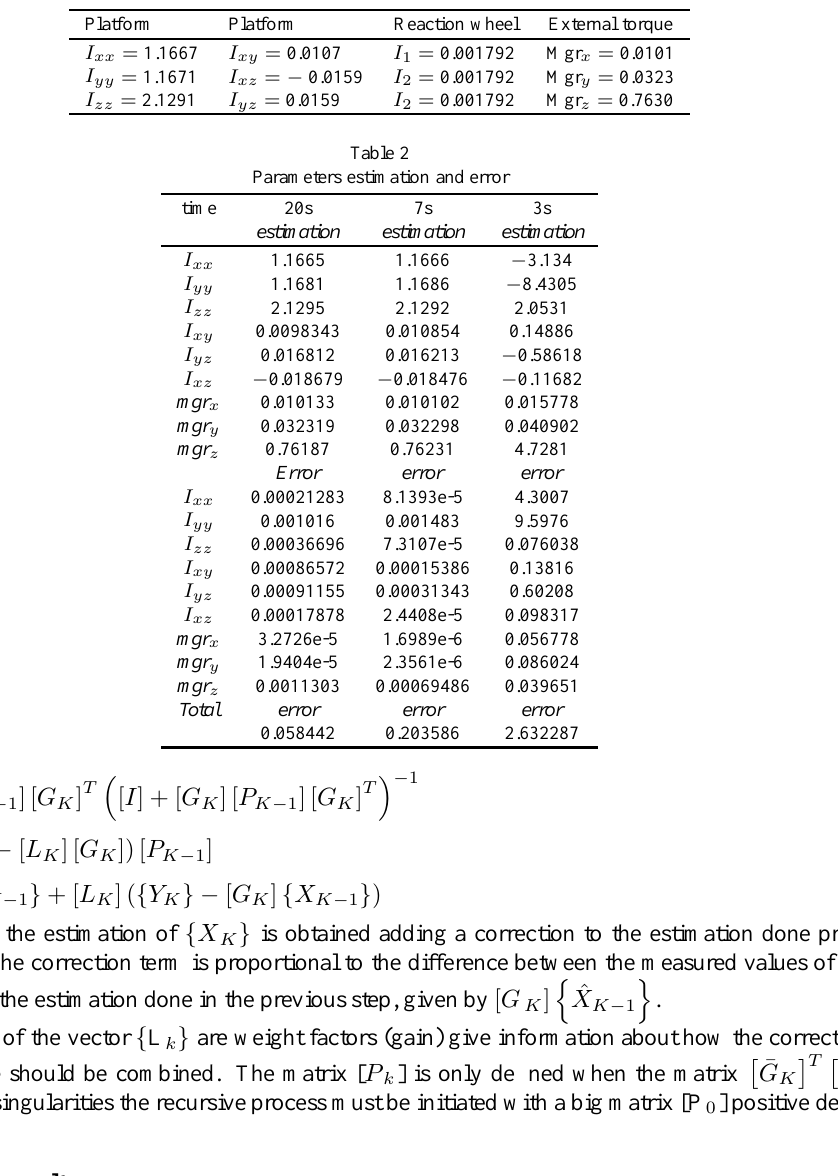
Table 1 System data used in the estimation process